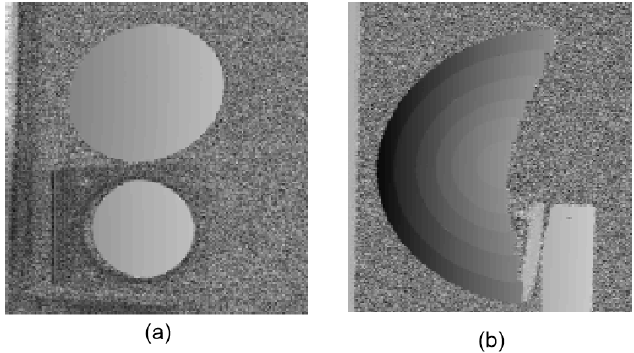
Figure 12. Unwrapped phase maps of the measured specular objects. ( a ) Two separate specular objects; ( b ) Discontinuous fan-shaped mirror step.